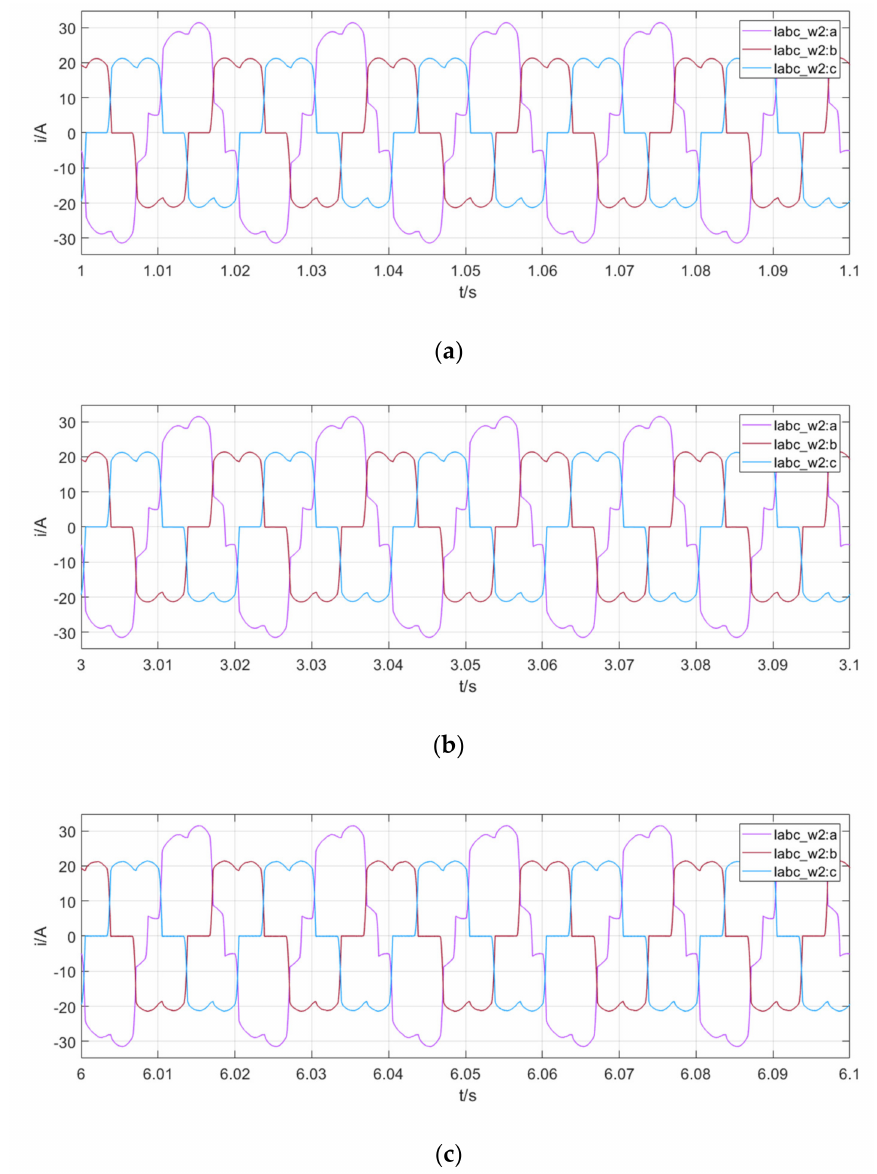
Figure 14. The load-side winding current waveform under different operating scenarios. ( a ) Dynamic current responses without any filtering device. ( b ) Dynamic current responses considering the 5th and 7th fully tuned branches. ( c ) Dynamic current responses under the proposed HIAF